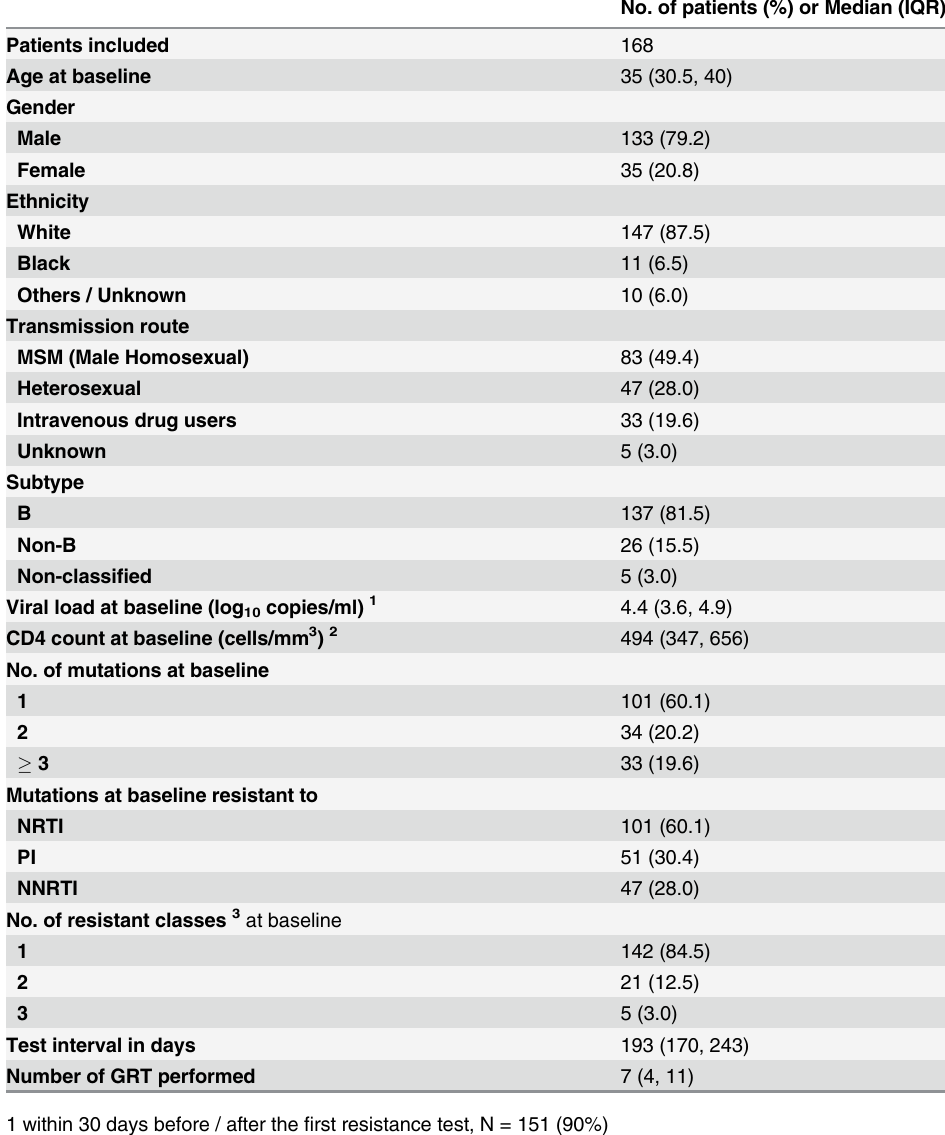
Table 1. Basic characteristics of study